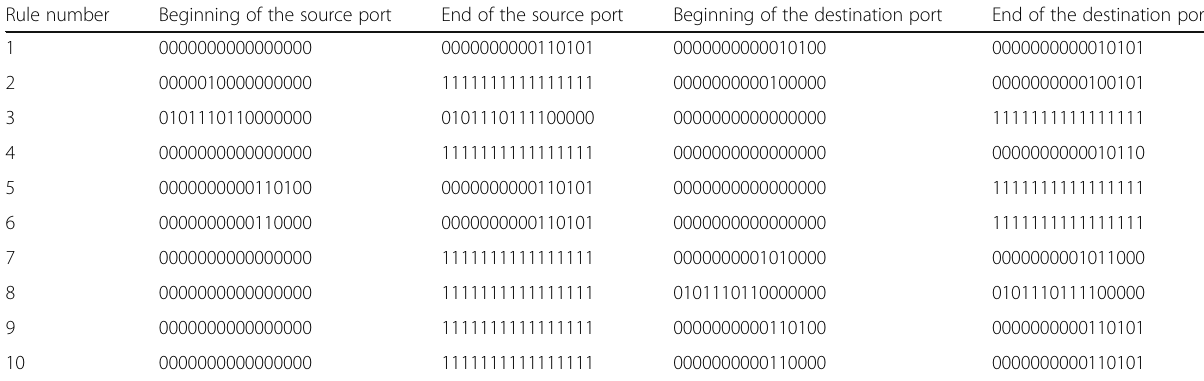
Table 1 A set of binary rules including the two fields of source and destination port